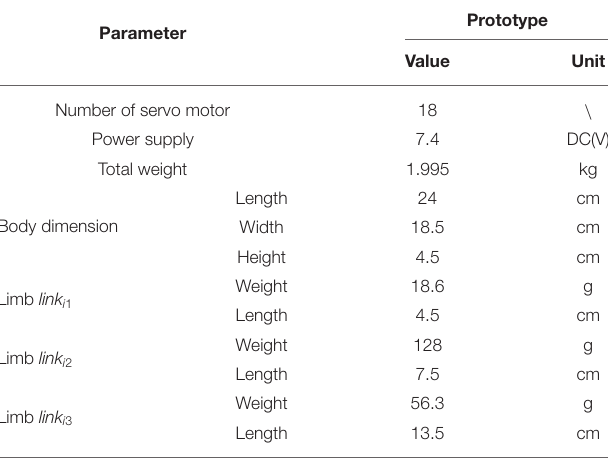
Prototype Value Unit